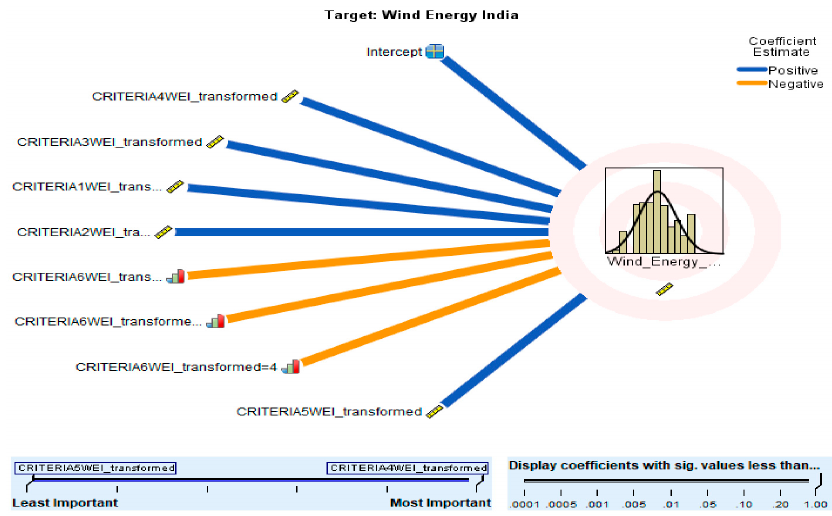
Figure 9. WE India GCV Criteria. Source: ALM Analysis SPSS by Author.